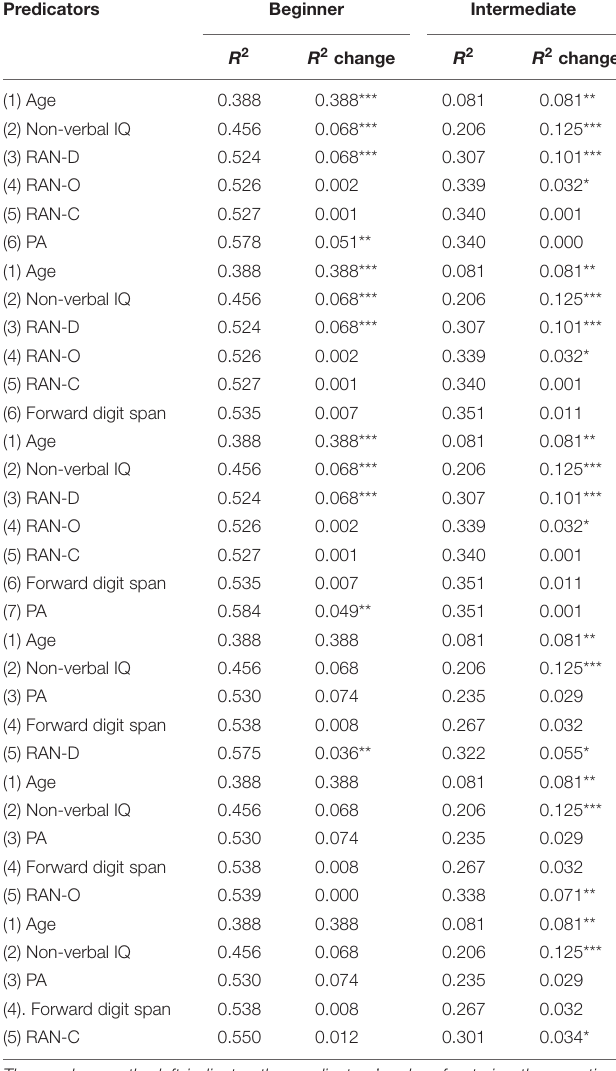
TABLE 4-2 | Summary of hierarchical multiple regressions that tested the predictive power of various component skill measures for Chinese word reading. Predicators